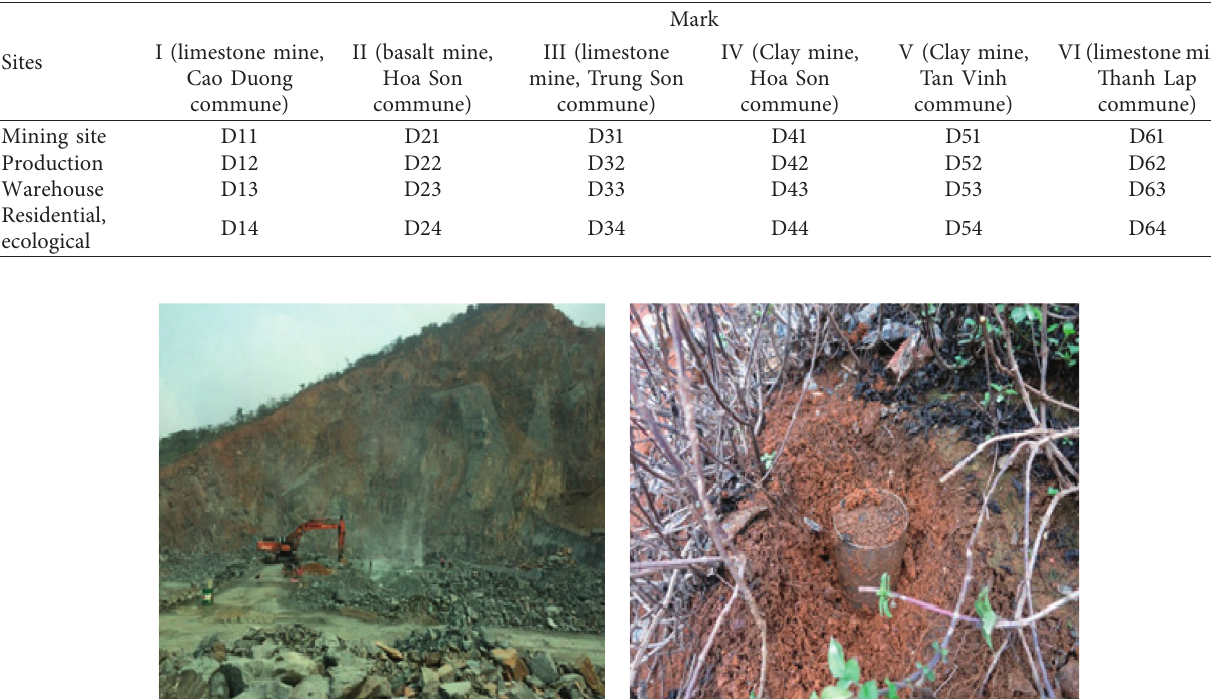
Table 1: Soil sampling sites at 6 mines.